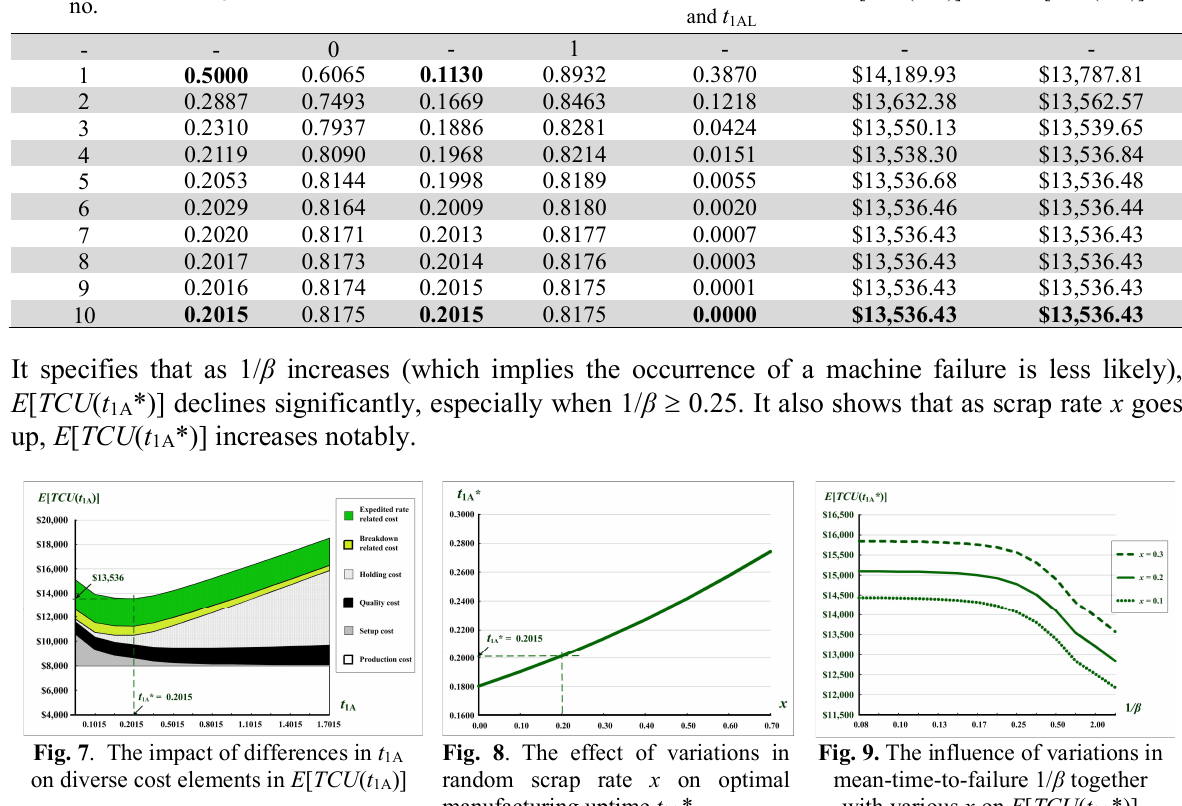
Fig. 9. The influence of variations in random scrap rate x on optimal mean-time-to-failure 1/ β together manufacturing uptime t 1A * with various x on E [ TCU ( t 1A *)]